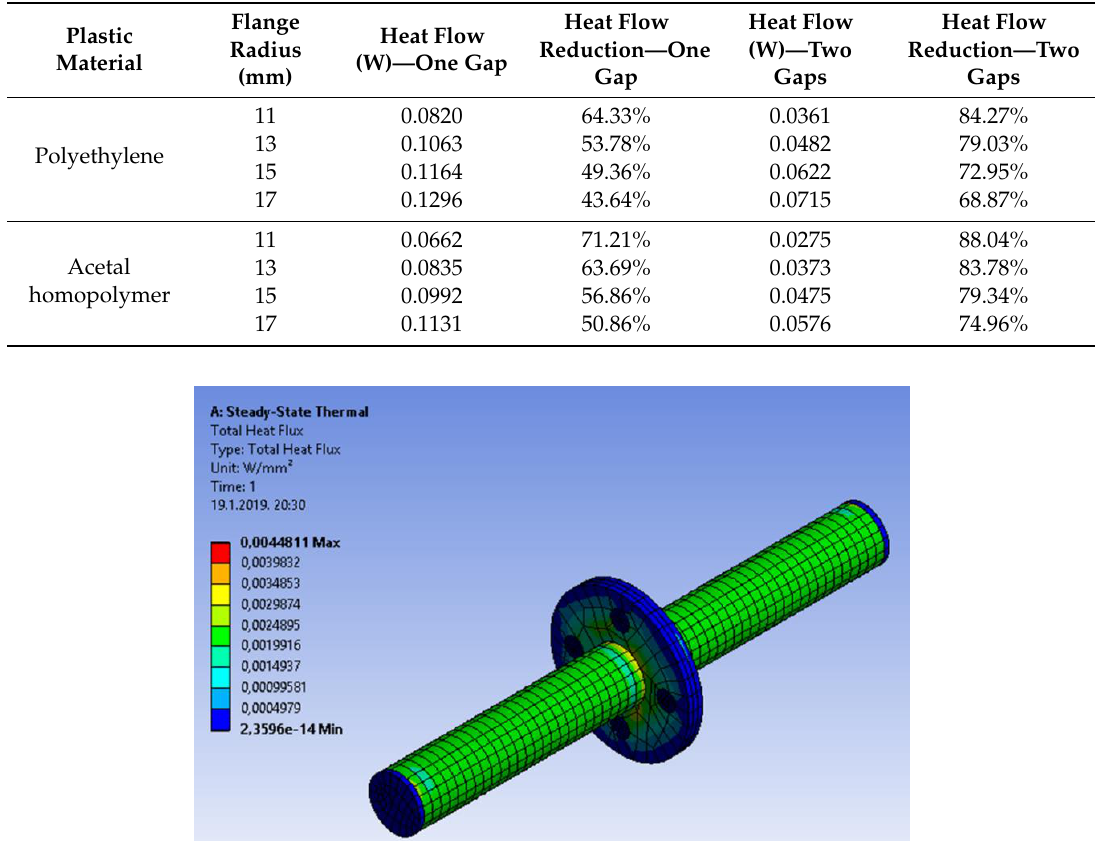
Figure 8. Calculated distribution of heat-flow density for adiabatic line with one gap .